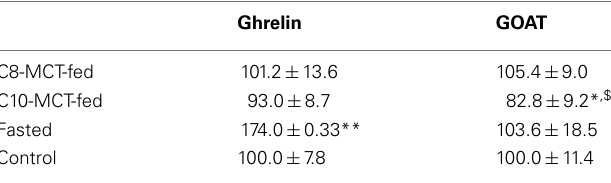
Table 3 | Expression levels of ghrelin and GOAT mRNAs in stomachs of mice under different nutritional conditions.